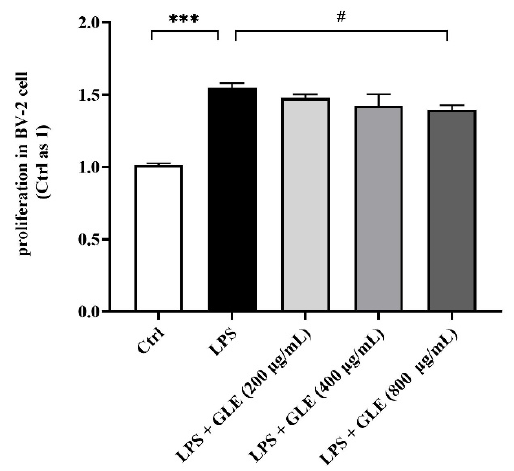
Figure 4. The effect of GLE on proliferation activity in LPS-induced BV-2 cells. Values are expressed as mean ± SEM of BV2 proliferation activity from three independent experiments. ***: p < 0.001, Ctrl group vs. LPS group; #: p < 0.05, LPS group vs. GLE treatment groups. All experiments were re- peated at least in triplicate.